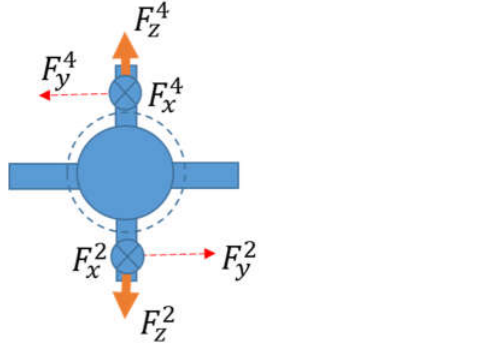
Figure 4. The dotted circle indicates the cavity intersecting the rudders. = , = − , = − .